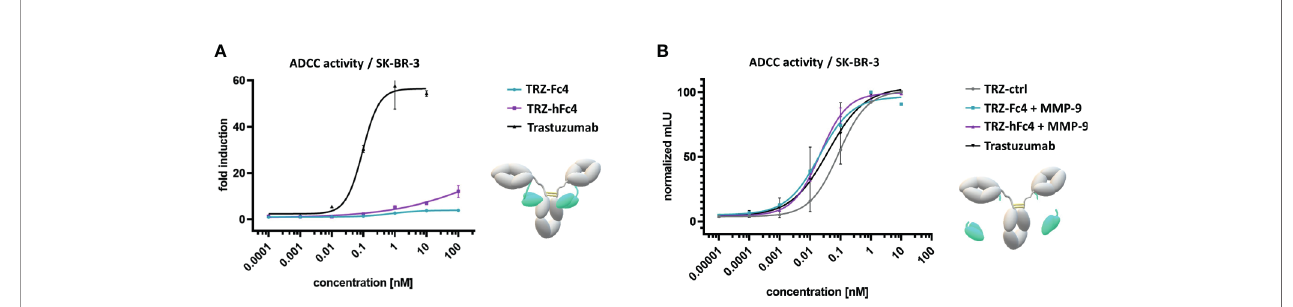
FIGURE 4 | ADCC reporter cell assay using Her2-positive SK-BR-3 cells. (A) Cells were incubated with a serial dilution of the Fc-tamed antibody variants TRZ-hFc4 or TRZ-Fc4. Trastuzumab served as a positive control. The assay was performed in the presence of MMP-2/MMP-9 inhibitor. (B) Cells were incubated with a serial dilution of MMP-9 cleaved TRZ-hFc4 and TRZ-Fc4 as well as trastuzumab and TRZ-ctrl. Fold induction: ratio of mean luminescence units (mLU) of the respective antibody sample and the blank sample (no antibody). Error bars represent the standard deviation derived from experimental